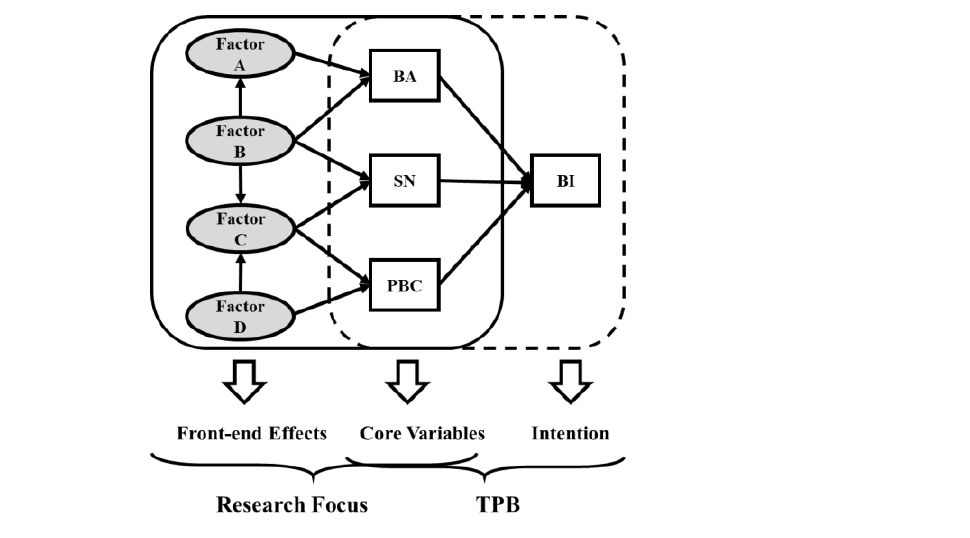
Figure 1. The hypothetical structural equation model. Note: BA, behavioral attitudes; SN, subjective norms; PBC, perceived behavioral control; BI, behavior intention; TPB, theory of planned behavior.